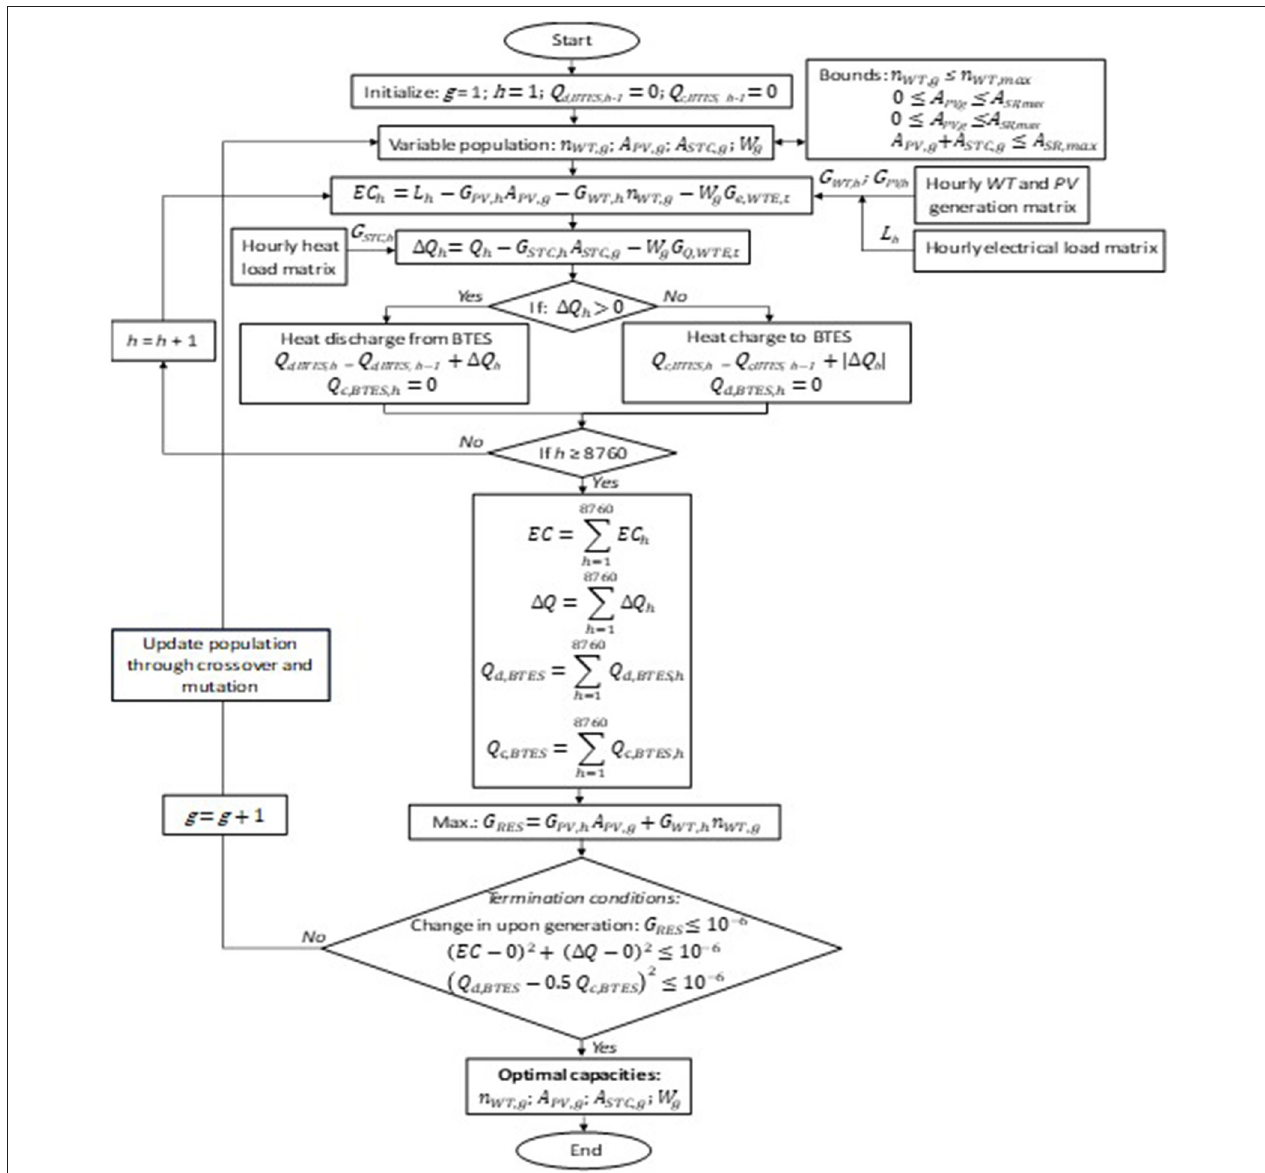
FIGURE 1 | Proposed optimization